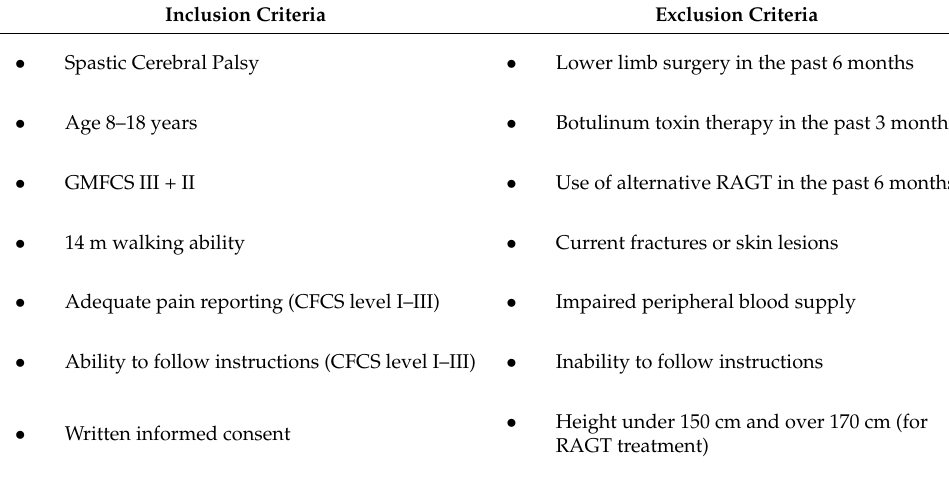
Table 1. Inclusion and exclusion criteria (after